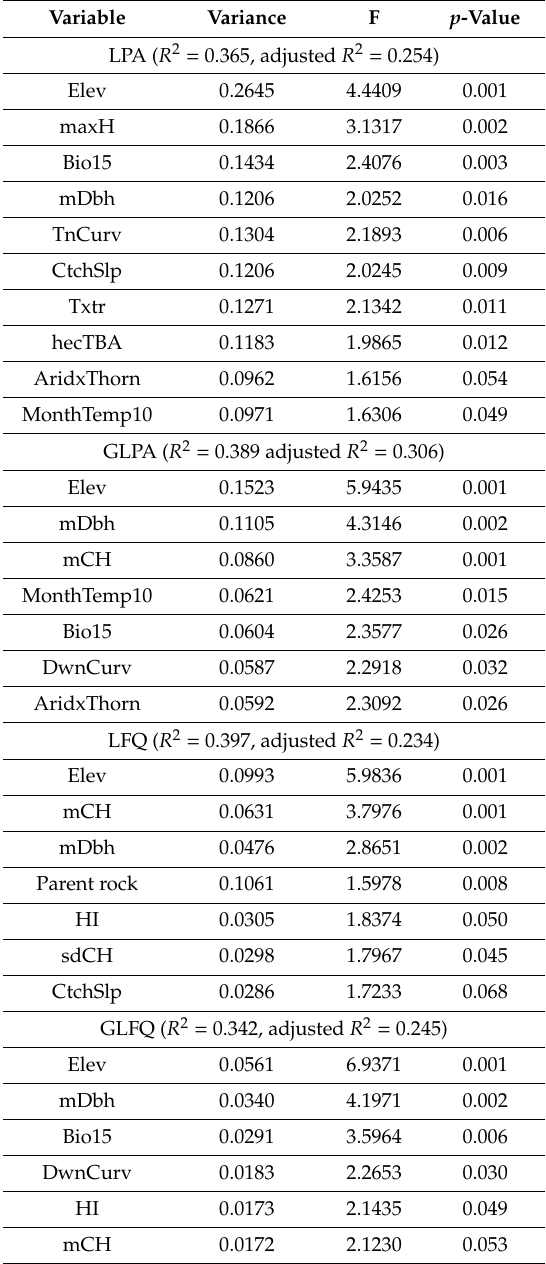
Table 3. The variance of the significant explanatory variables used in the stand-level redundancy analysis (RDA) with LPA, GLPA, LFQ, and GLFQ data